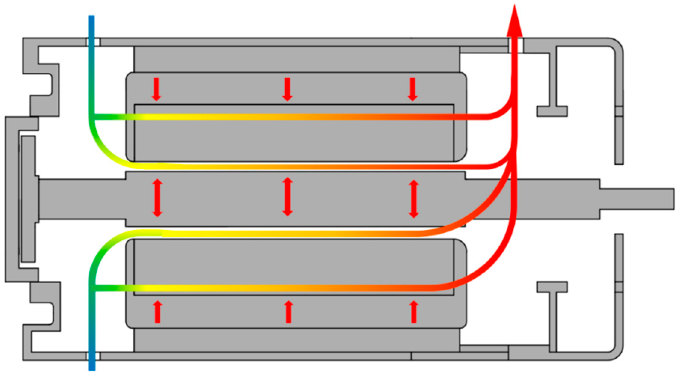
Figure 25. Forced cooling air path in the motor.